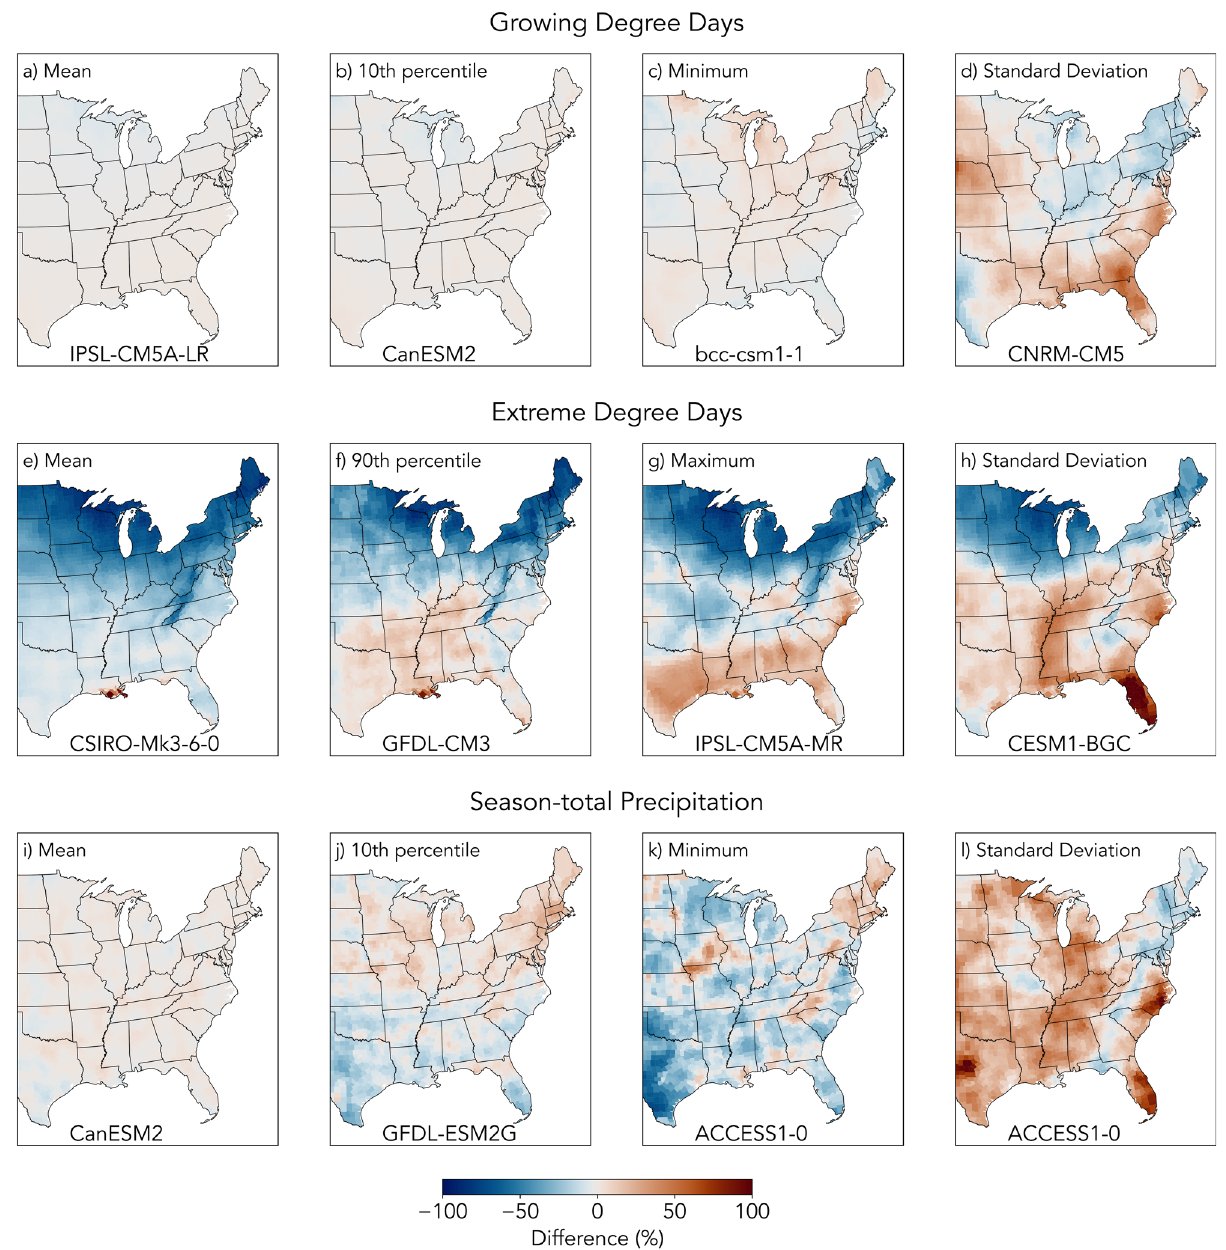
Fig. 3 County-level evaluation of NEX-GDDP predictor variable hindcasts. County-level differences between the median-performing NEX-GDDP model and observational data, for selected summary statistics of the historical distribution of each climate variable in the yield model: growing degree days (top row) ( a – d ), extreme degree days (middle row) ( e – h ), and season-total precipitation (bottom row) ( i – l ). For each summary statistic and variable, the median-performing model (reported at the bottom of each panel) is selected after taking an unweighted average over all counties east of the 100th meridian west and comparing to the equivalent observational data. For extreme degree days, we report on the 90th percentile ( f ) and maximum ( g ) rather than the 10th percentile and minimum since extreme degree days negatively impact